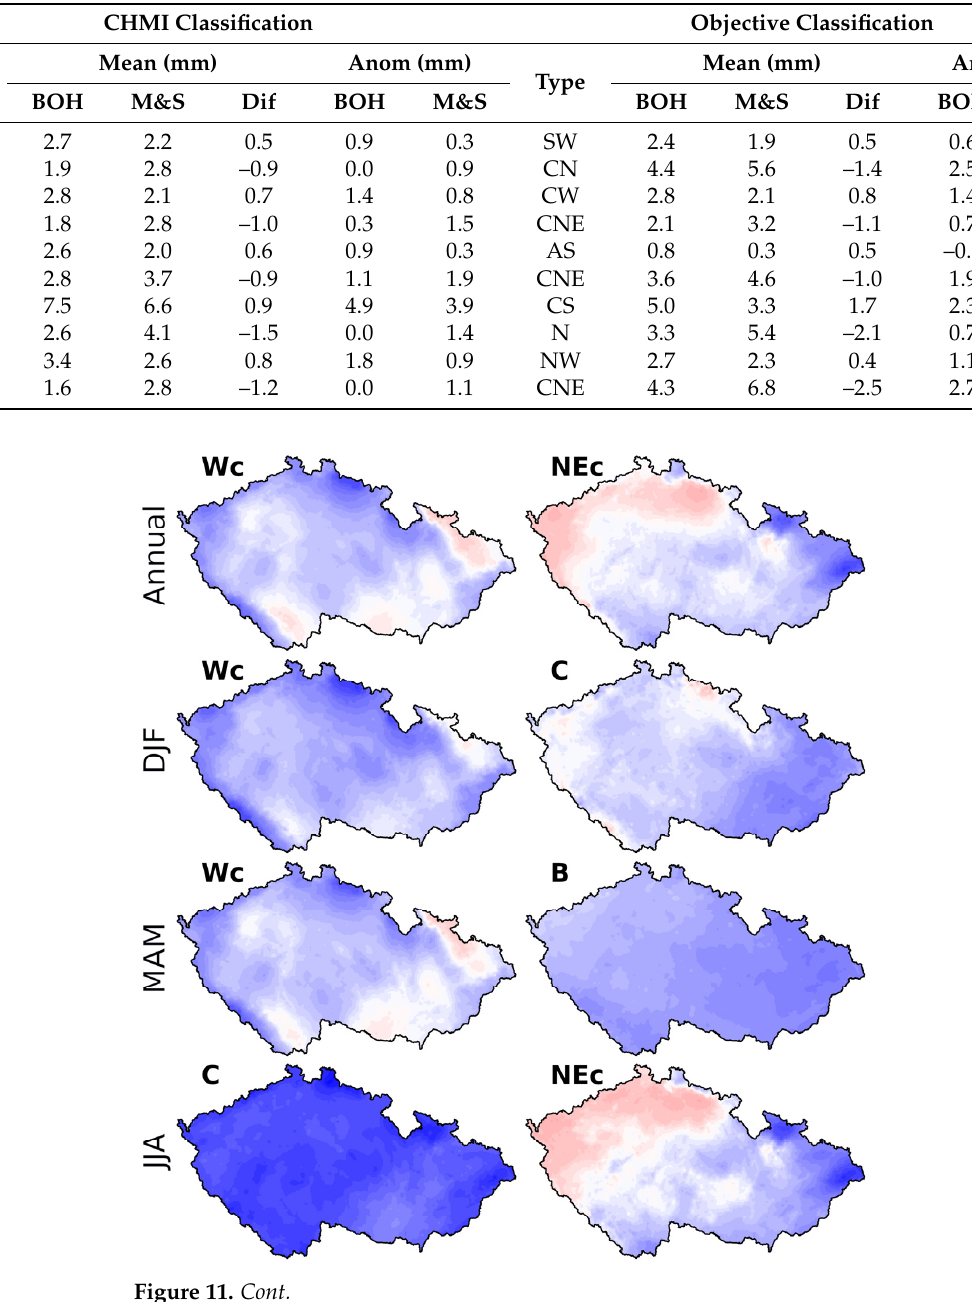
Figure 11. Anomalies of the annual and seasonal daily mean precipitation (the 1961–2020 reference period) for the circulation types under CHMI classification with the largest difference in the daily mean precipitation in favor of BOH ( left column ) and M&S ( right column ). Included types: Wc, west cyclonic; NEc, northeast cyclonic; C, cyclone over central Europe; B, trough over central Europe; Wcs, west cyclonic with southern pathway.